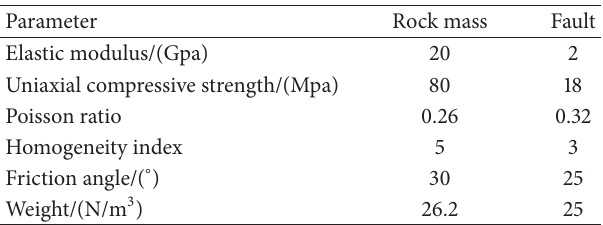
Table 4: Mechanical parameters used in the numerical model. Parameter Rock mass Fault Elastic